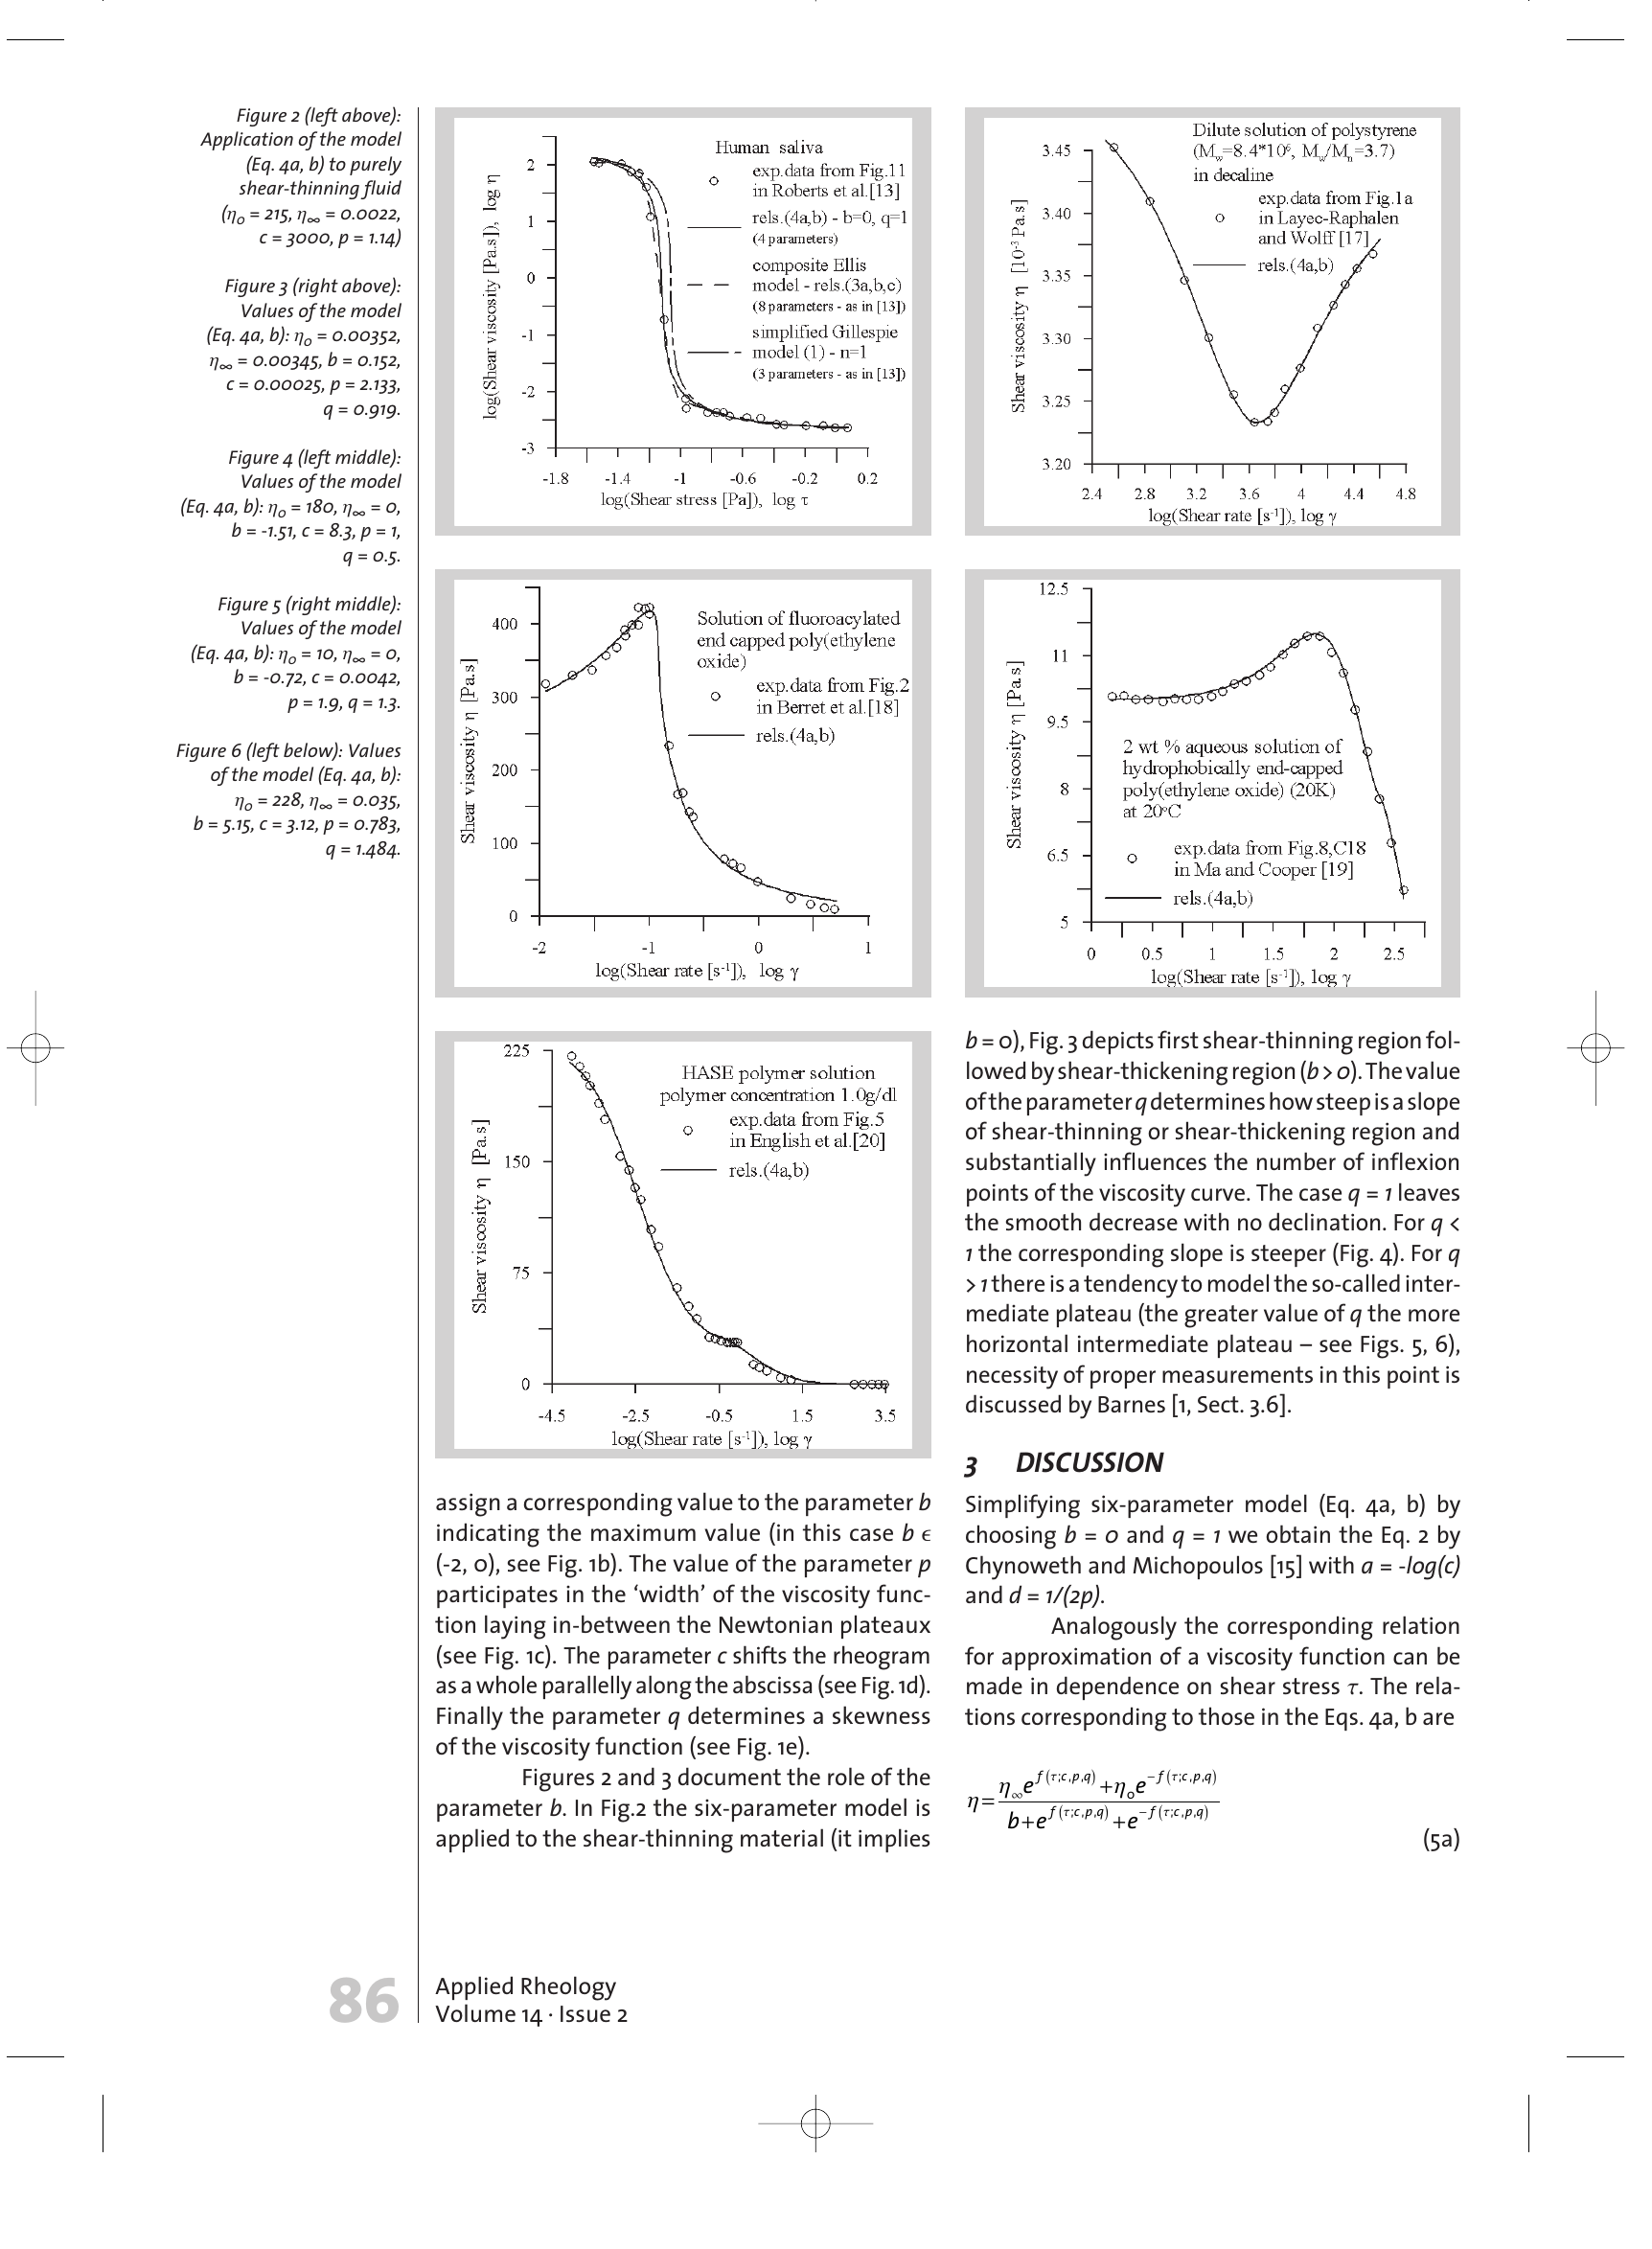
Figure 2 (left above): Application of the model (Eq. 4a, b) to purely shear-thinning fluid ( h 0 = 215, h ∞ = 0.0022, c = 3000, p = 1.14) Figure 3 (right above): Values of the model (Eq. 4a, b): h 0 = 0.00352, h